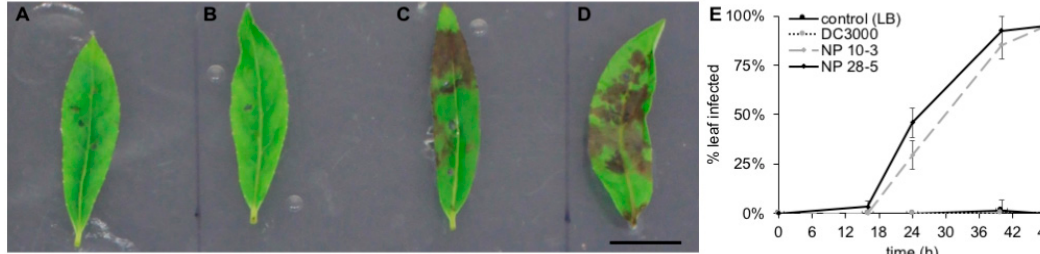
Figure 3. Pseudomonas syringae isolates from P. trichocarpa induce lesion formation on leaves. Leaves were cut from 3-month-old rooted P. trichocarpa BESC819, placed on agar infused with 1% glucose and 1 × Hoagland’s basal salt mixture, and wounded 3 × with a sterile pipette tip. Aliquots (10 µ L, 8 × 10 5 cells / mL) of ( A ) R2A media, ( B ) P. syringae pv. tomato DC3000, ( C ) P. syringae sp. NP10-3, or ( D ) P. syringae sp. NP28-5 were spotted onto each leaf wound and plates were incubated for 24 h at 25 °C. Scale bar, 10 mm. ( E ) Lesion development over 48 h on P. trichocarpa leaves. Error bars, standard deviation of three biological replicates with three leaves in each treatment group in each replicate.